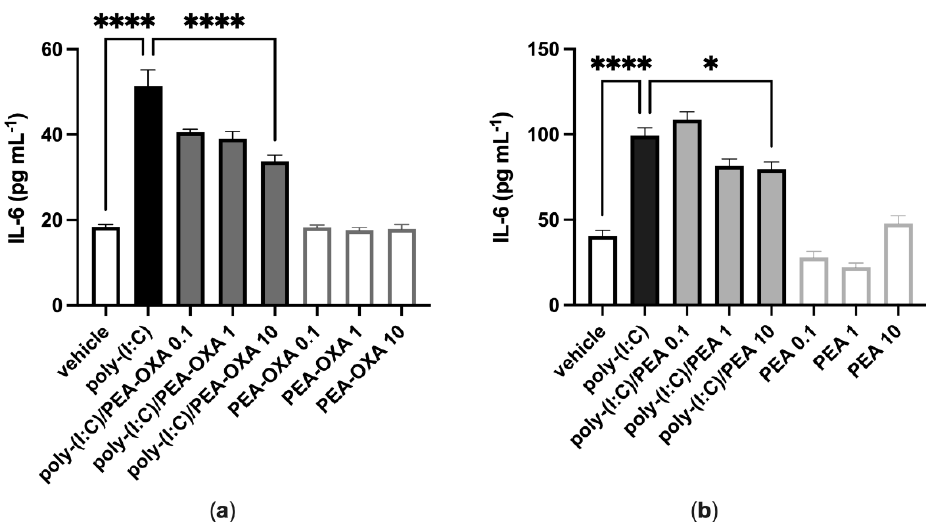
Figure 1. PEA-OXA and PEA reduce IL-6 release from poly-(I:C)-stimulated A549 cells. ( a ) IL-6 release was measured after stimulation of A549 cells with poly-(I:C) (100 μ g mL -1 ) in the presence or absence of PEA-OXA (0.1, 1 and 10 μM) for 6 h at 37 °C in a 5% CO 2 atmosphere; ( b ) IL-6 release was measured after stimulation of A549 cells with poly- (I:C) (100 μg mL -1 ) in the presence or absence of PEA (0.1, 1 and 10 μM) for 6 h at 37 °C in a 5% CO 2 atmosphere. Each bar shows the mean ± SEM of independent experiments ( n = 4). p -values were determined by ANOVA followed